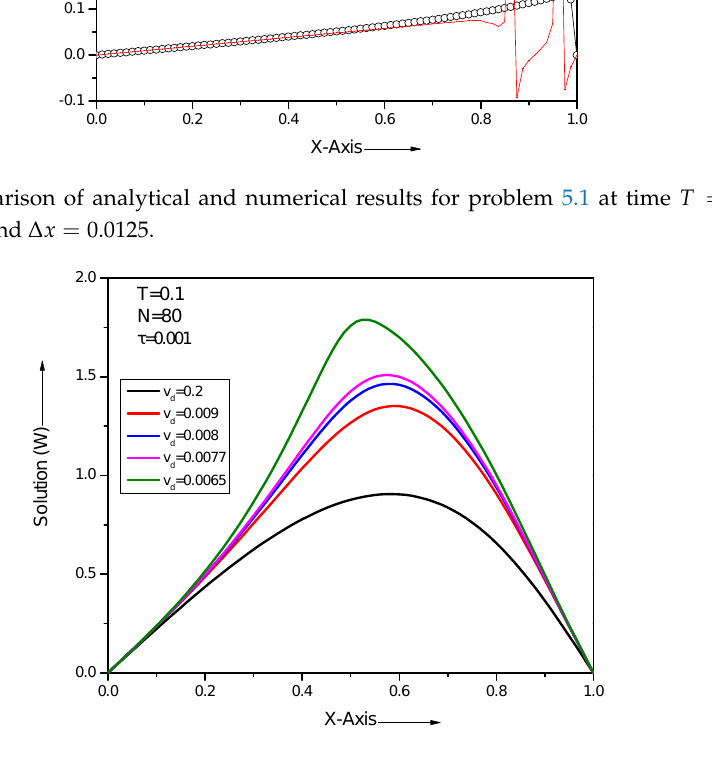
Figure 5. Numerical results for different small values of ν d with τ = 0.001 and ∆ x = 0.0125 of problem 5.1 at time T =